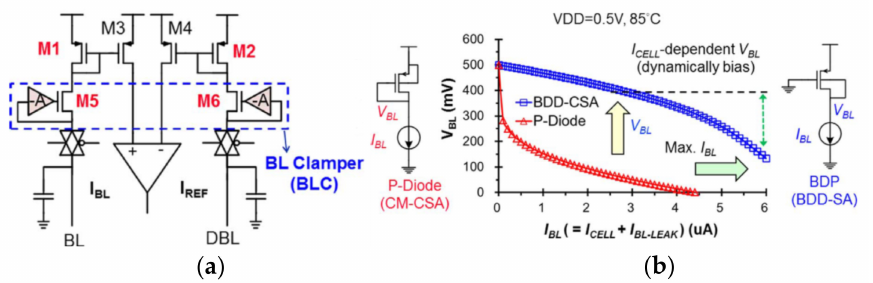
Figure 17. ( a ) The traditional sensing scheme; ( b ) VBL of BDD-SA and CM-CSA across various IBL [87].